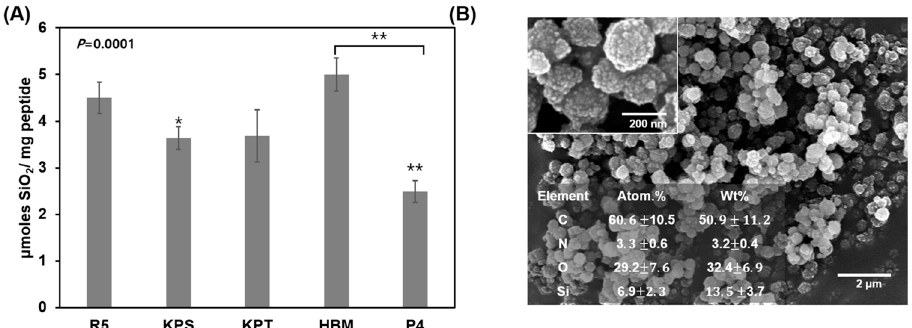
Figure 1. Silica deposition by P4 peptide. ( A ) Comparison of the amount of silica formed by P4 with those formed by other silica-forming peptides. The specific silica deposition is µ moles of SiO 2 per 1 mg silica-forming peptide. The p value obtained following one-way ANOVA was 0.0001. Furthermore, compared to R5 or HBM, P4 showed about 50% silica-forming ability (* p < 0.05, ** p < 0.01 vs. R5 or HBM). ( B ) SEM images of silica particles formed by P4 peptide and their component ratio analyzed by Energy Dispersive X-ray Spectroscopy (EDX). The image is a 20,000 × magnification, and the inside picture is an 80,000 × magnification.